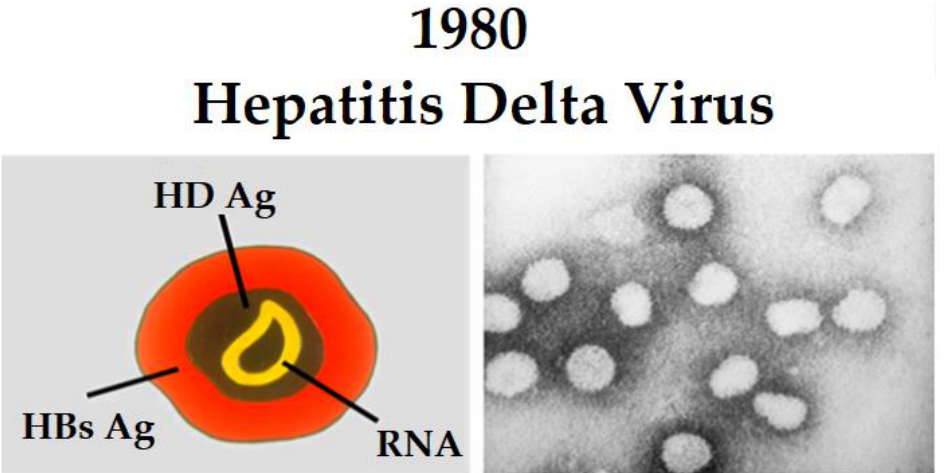
Figure 1. Hepatitis delta virus. Defective, dependent on biological help from the HBV, present only in HBsAg-positive subjects (HBsAg carriers). Virion: 36 nm particle, enveloped in HBsAg. Genome: